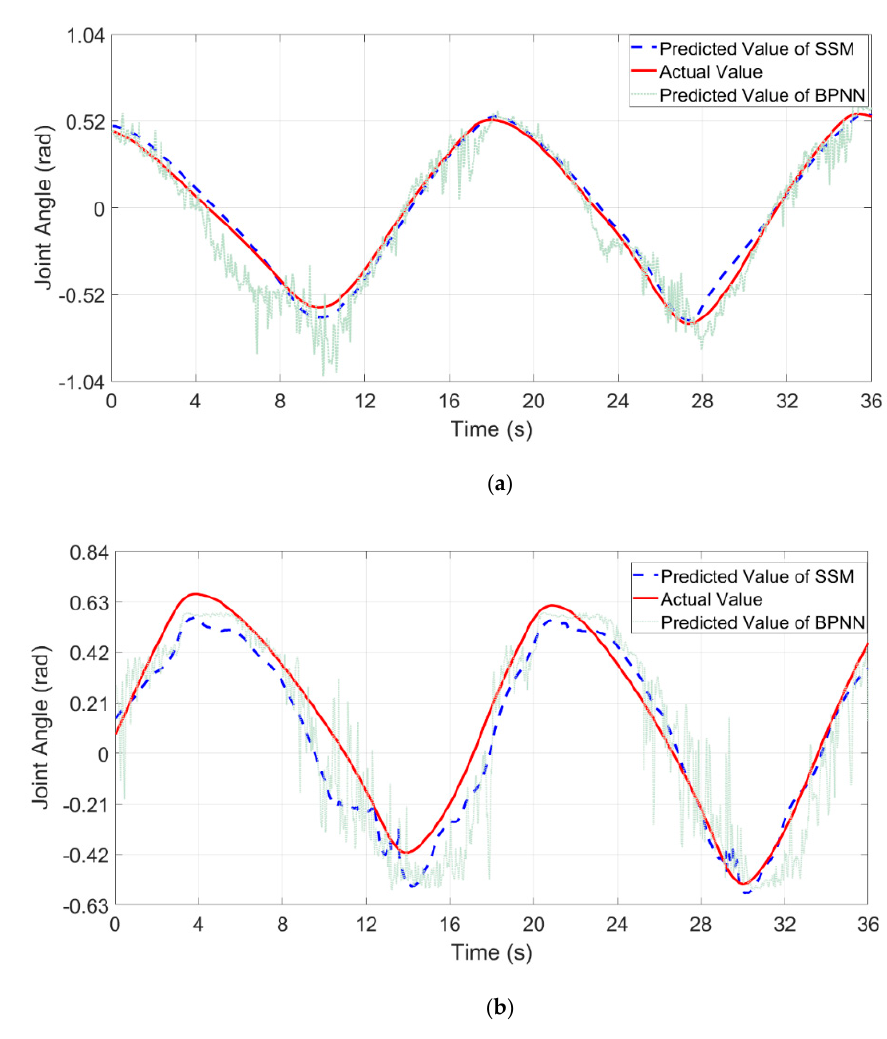
Figure 11. Joint prediction performance comparisons between the BPNN and SSM. (a) S1, (b) S2.